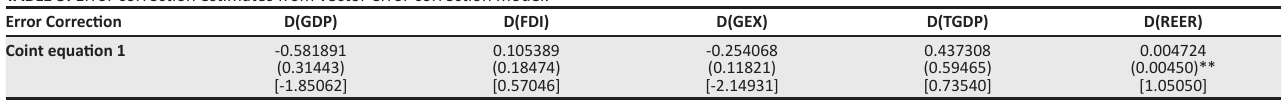
Standard errors in ( ) and t -statistics in [ ]. **, denotes the rejection of null hypothesis at 5% level of significance. FDI, foreign direct investment, GDP, gross domestic product; GEX, government expenditure; TGDP, total trade (exports-imports) to real GDP; REER, real effective exchange rate.